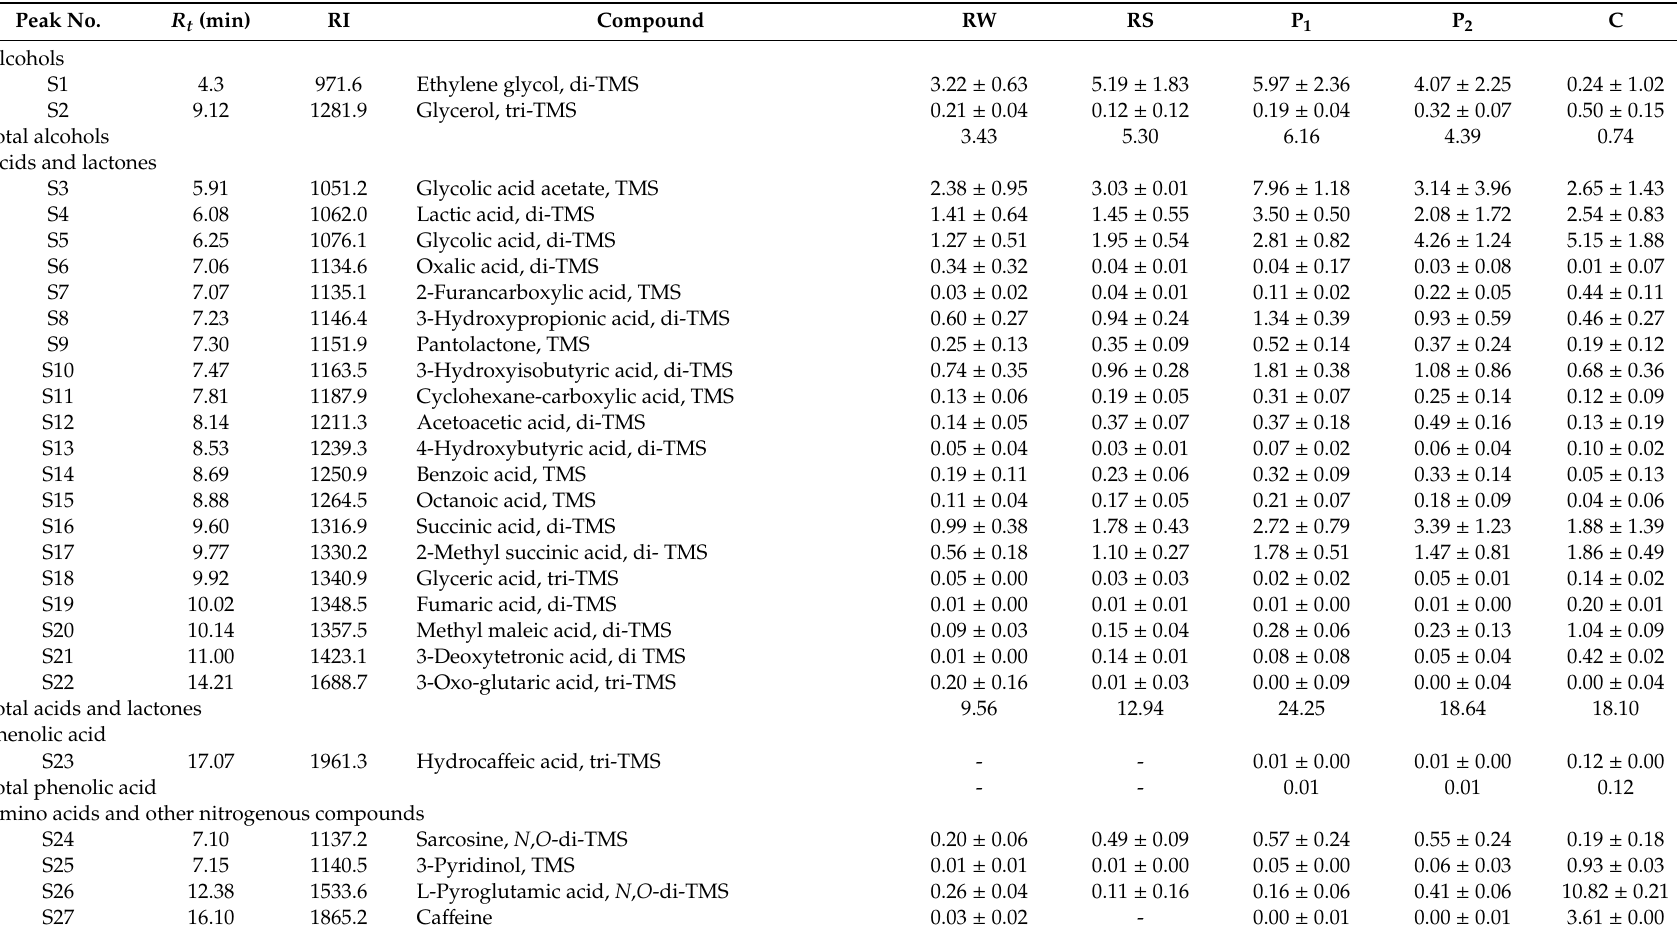
Table 2. Relative percentages of silylated primary metabolites in raw pits (RW), roasted pits (RS), pit product one (P 1 ), pit product two (P 2 ) and co ff ee product (C) using GCMS. Each value represents mean ± S.D. ( n = 3). Peak